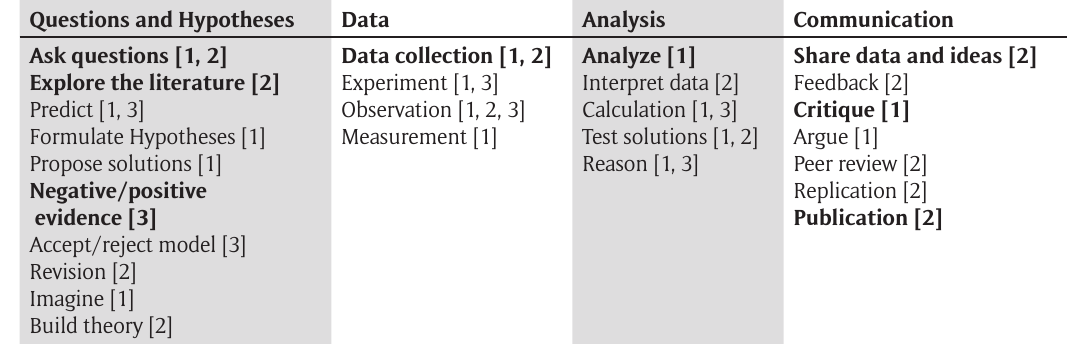
Table 1: The activities of the scientific research process. The number by each activity indicates the model from which it came (NAS 2012 [1]; Berkeley 2015 [2]; Giere 1991 [3]). The bold text in the table indicates the activities used in the Green Peas